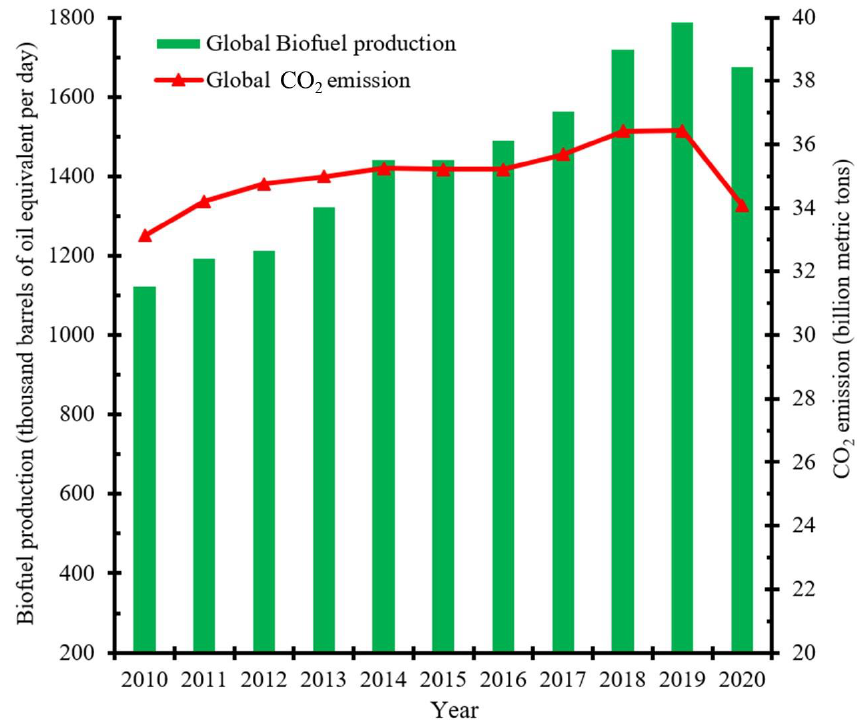
Figure 1. Global biofuel production (2010–2020) and global CO 2 emission (2010–2020). Compiled by the authors from [5,6].